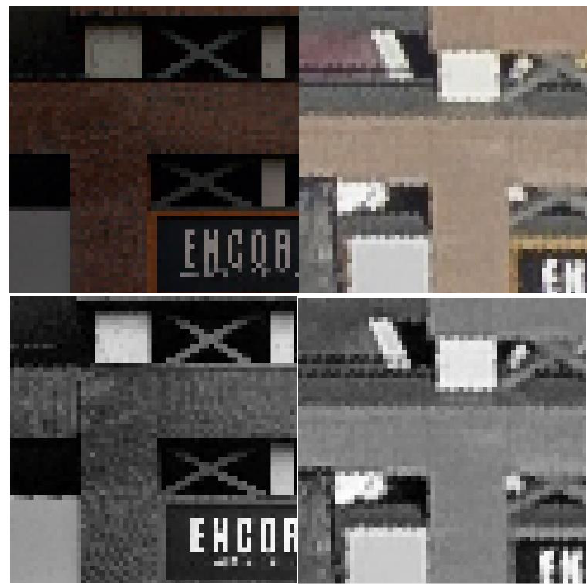
Figure 8. Top: Image projections of MM and aerial oblique image onto grid in 3D-space. Both images have the same pixel spacing and share a similar perspective. Bottom: Same images after Wallis